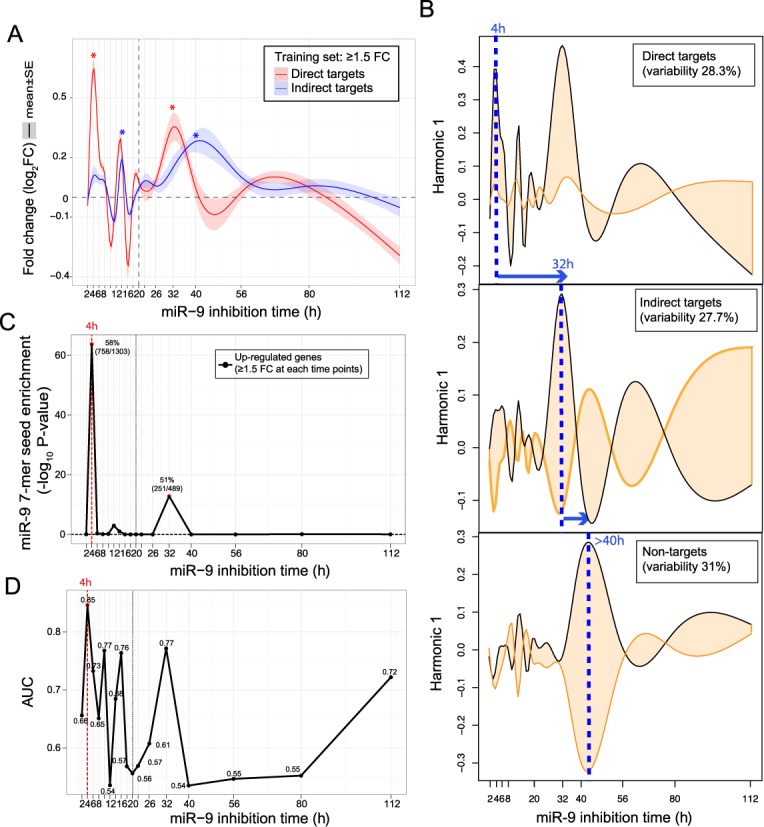
Time-series curves of gene expression fold change (FC) following miR-9 inhibition show a multiphasic response, with initial miR-9-specific direct target response occurring by 4 h. (A) Red curve shows the FC response (mean ± SE) for a set of genes computationally enriched for direct miRNA target genes (see ‘Materials and Methods’ section for set definitions). This shows an initial direct inhibition response by 4 h and downstream responses. By contrast, the blue curve shows FC response (mean ± SE) for a set of of genes enriched for indirect miR-9 target genes and does not show a substantial 4 h response. Asterisk denotes highly significantly (P < 1E-3) above background variance at other time points. Bands show SEM at each time point. (B) Functional PCA of computationally defined sets, from top to bottom: miR-9 direct target set, miR-9 indirect target set, non-target set (see ‘Materials and Methods’ section for set definitions). Shown are the first functional PCA harmonic which is the major variance component. Blue dashed line shows position of first major variance peak. Orange and black lines demarcate the variation limits of the mean when this variance component is added. The three sets show distinct dynamics with the major variance components commencing at progressively later time points for direct, indirect and non-targets, respectively: direct targets show a large asymmetric variance at early time points of 4 h and later at 32 h; indirect targets show predominantly symmetric variance at 32 h and non-targets show a major variance downstream after 40 h. (C) Significance of enrichment of miR-9 seeds relative to background, calculated separately for each time point, in genes showing ≥1.5 FC response. There are two statistically significant peaks, with a highly significant enrichment at 4 h, and a smaller, but still highly significant, peak at 32 h. This supports the hypothesis of an initial direct miRNA response at 4 h and a 32 h coherent secondary response. (D) Predictive performance of gene expression FC in discriminating miR-9 direct and indirect target gene sets, estimated separately for each time point. The highest predictive performance, measured by AUC of genes ranked by FC at each time point, is at 4 h. Good predictive performance is also seen downstream at 32 h.